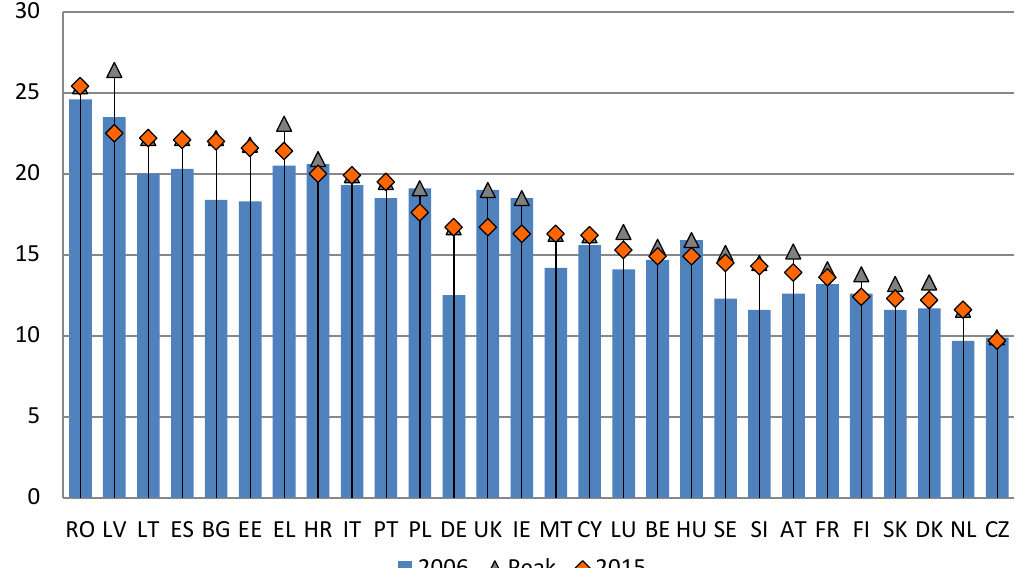
Figure 1. Headcount ratio in the EU-28 countries (2006, 2015 and period peak). Source: Own elaboration based on statistics from Eurostat. Notes: (i) Countries appear ranked according to the highest at-risk- poverty rate in 2015. (ii) Croatia's data correspond to 2010 instead of 2006; Romania's data correspond to 2007 instead of 2006